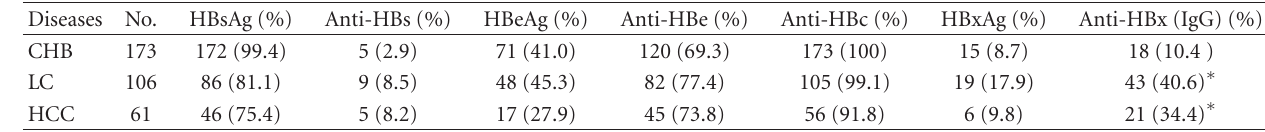
Table 1: Examination of HBV serum markers in CHB, LC, and HCC patients.